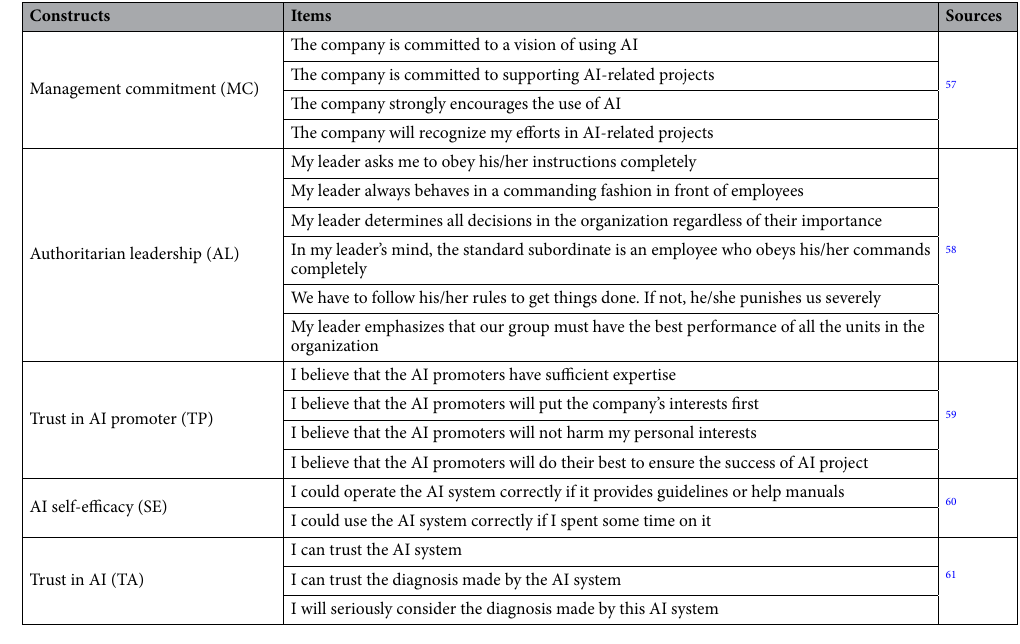
Table 4. Measurement